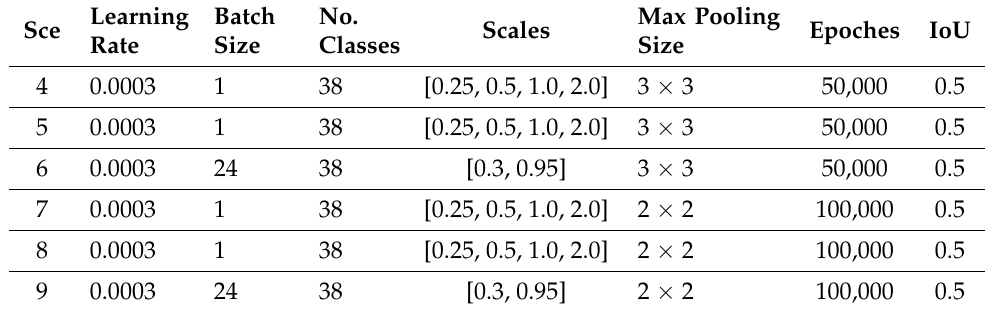
Table 4. Parameters for Scenarios 4 to